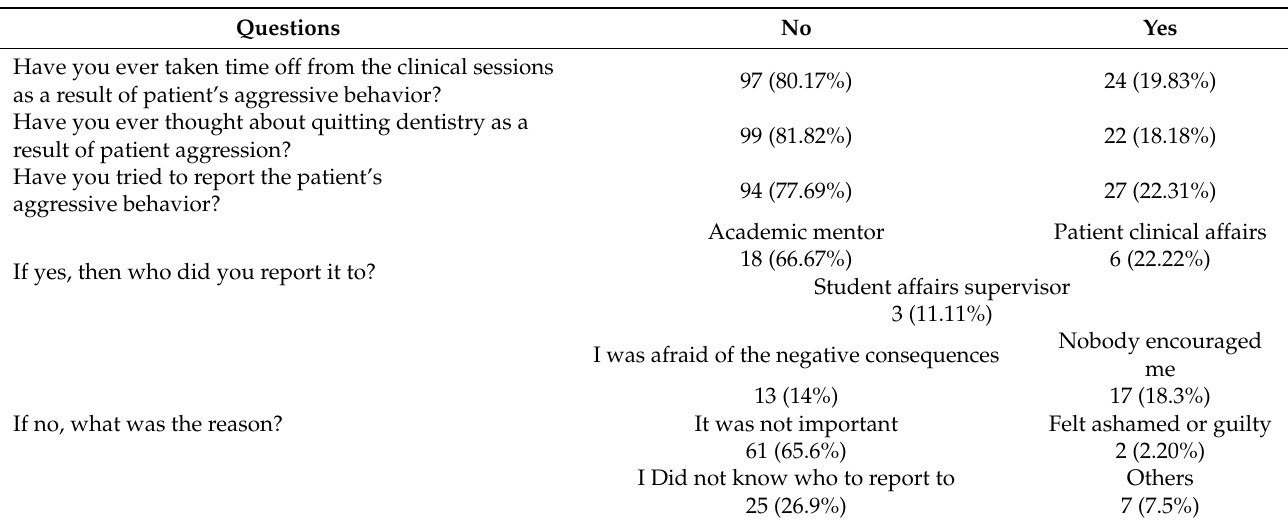
Table 4. Response of study participants towards patients’ aggressive